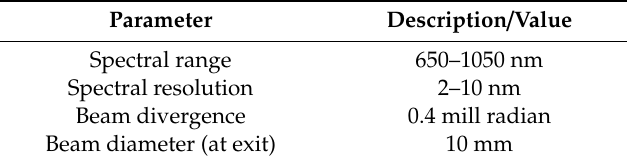
Table 1. The AOTF-HSL major parameter specifications.